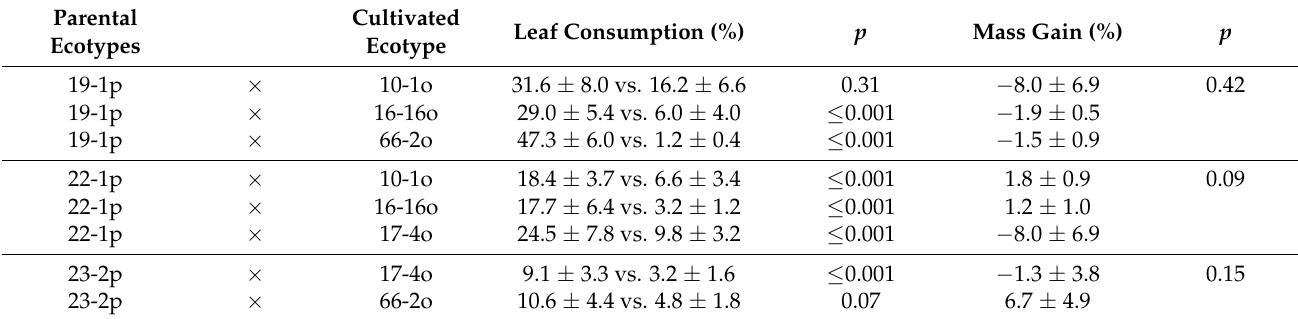
Table 1. Consumption of leaves and mass gain of Chilesia rudis for each comparison run in a choice assay. Values of p < 0.05 indicate significant differences according to Student’s t -test for consumption and for mass gain an ANOVA followed by Tukey’s test.